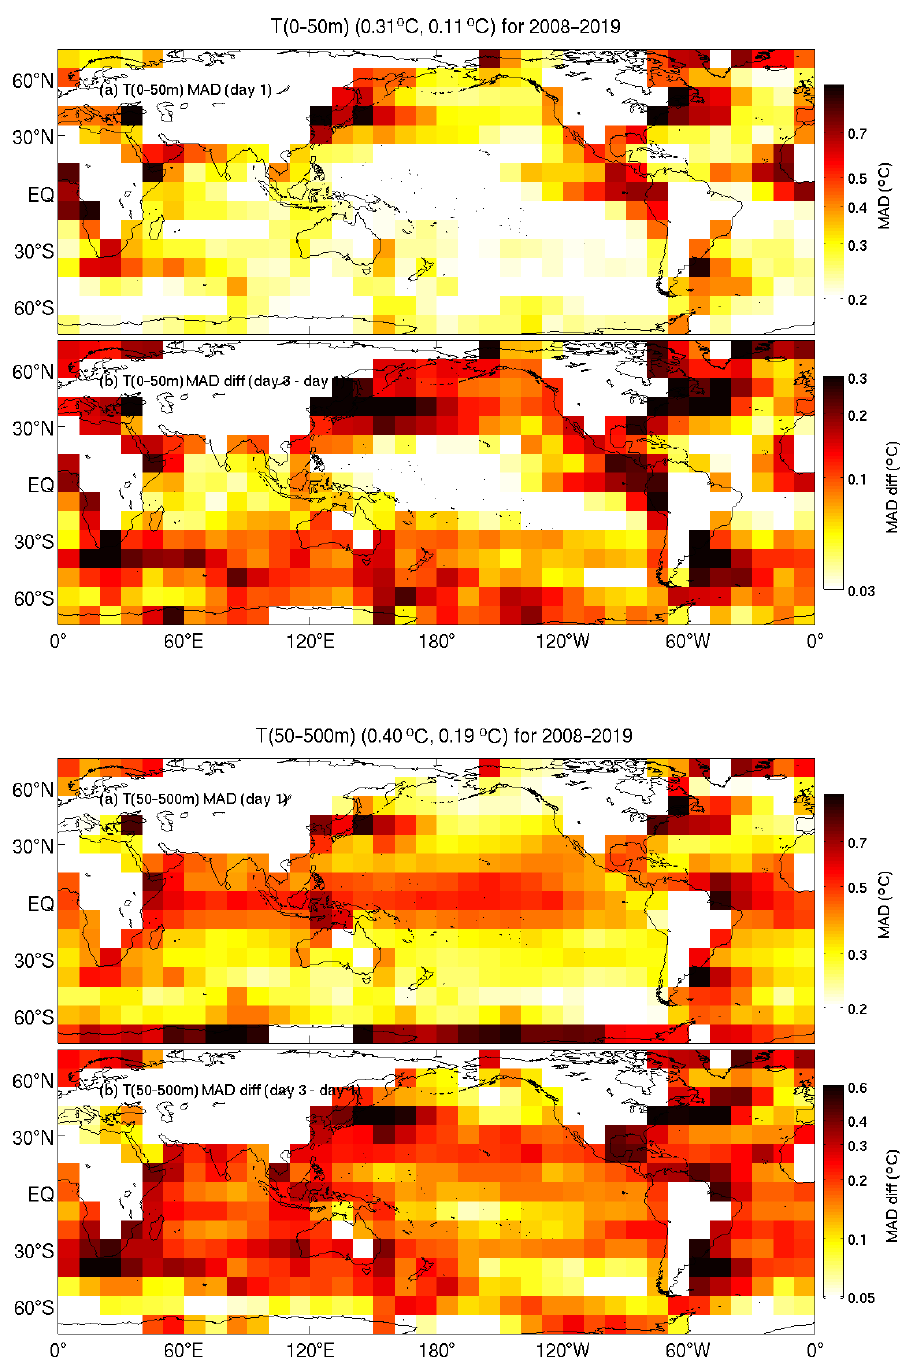
Figure 5. Binned mean absolute deviations of temperatures between 0 and 50m (top pair) and 50 and 500m (bottom), averaged over 2008–2019 from the first day (top of each pair) and day 3 minus day 1 (bottom of each pair).